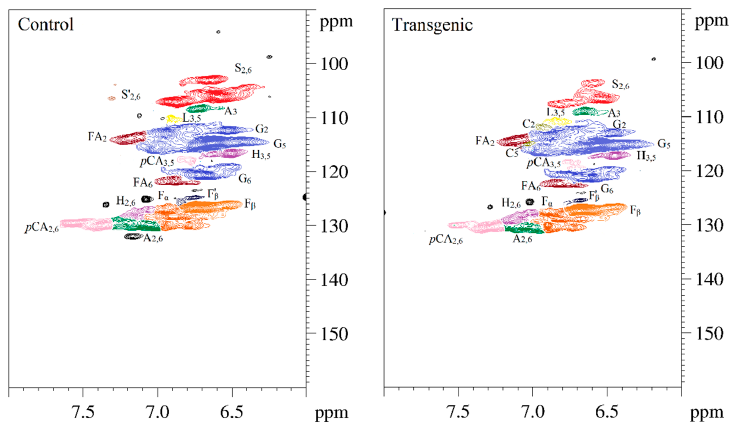
Figure 5. The 2D-HSQC NMR spectra of LCs from transgenic and control switchgrass. Table 4. The 2D-HSQC NMR attribution of switchgrass LCs.